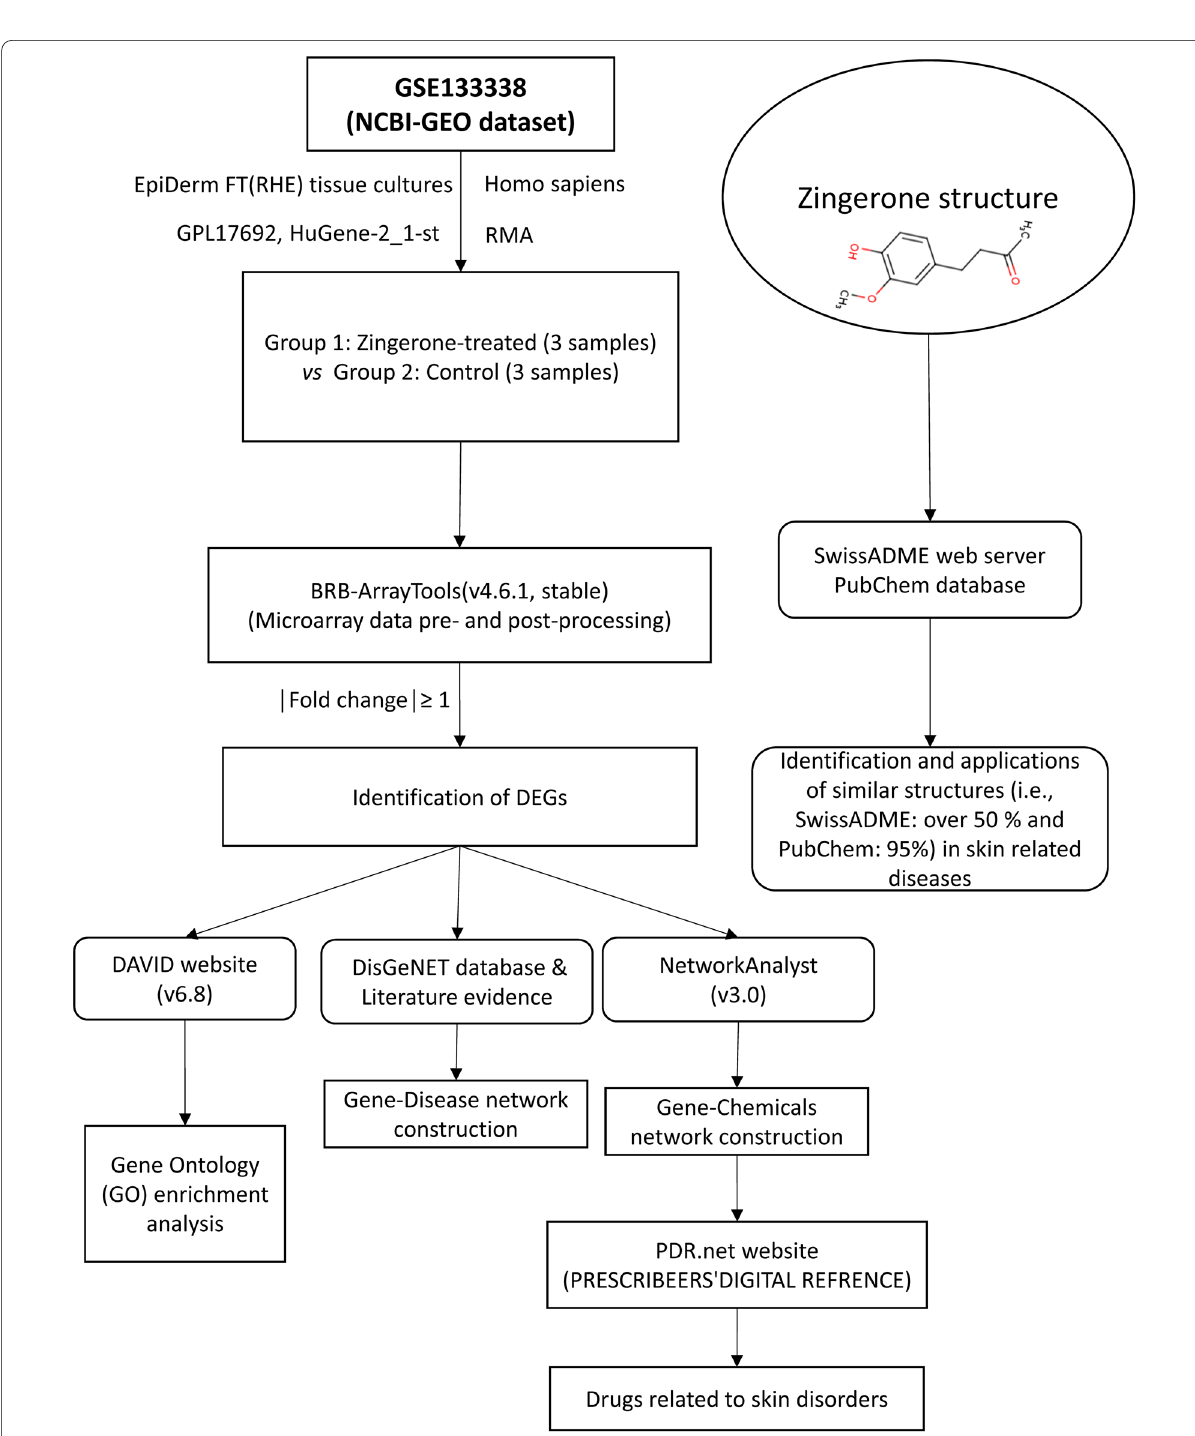
Fig. 1 The overall workflow of the systems biology and systems pharmacology